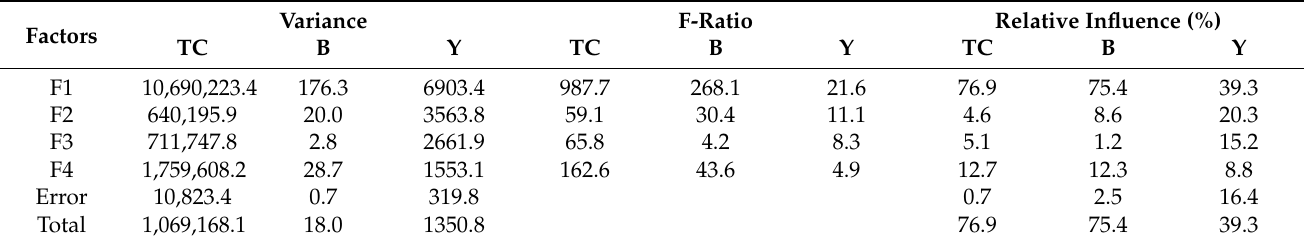
Table 3. Analysis of variance (ANOVA) results for total carotenoids, biomass, and